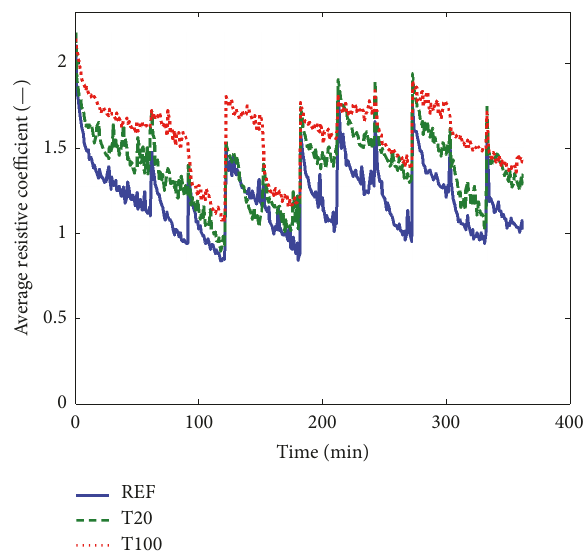
Figure 10: Measured resistive coefficient, average of experiments for each surface